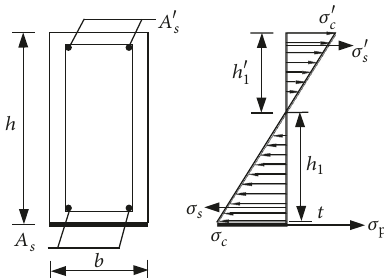
Figure 11: Stress distribution on cross-section of the RC beam after